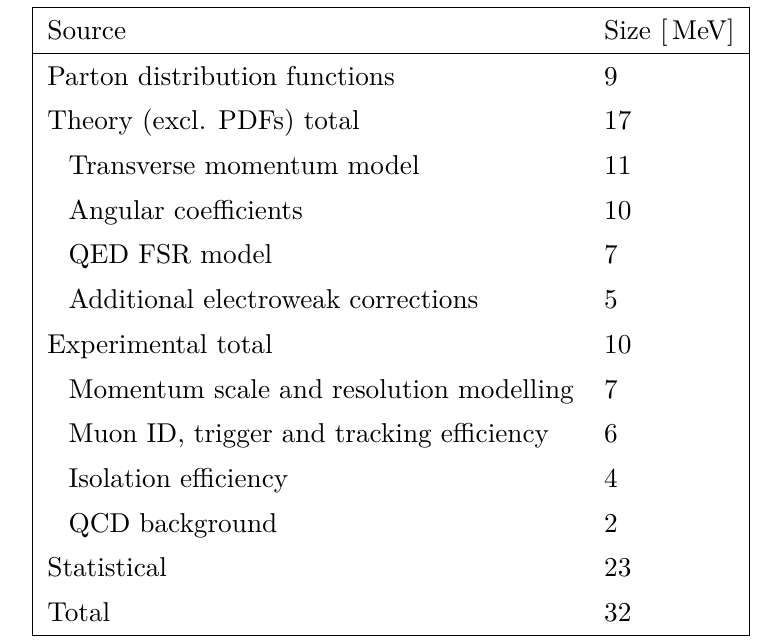
Table 6 . Contributions to the systematic uncertainty in m W . Negligible contributions below 1 MeV are not